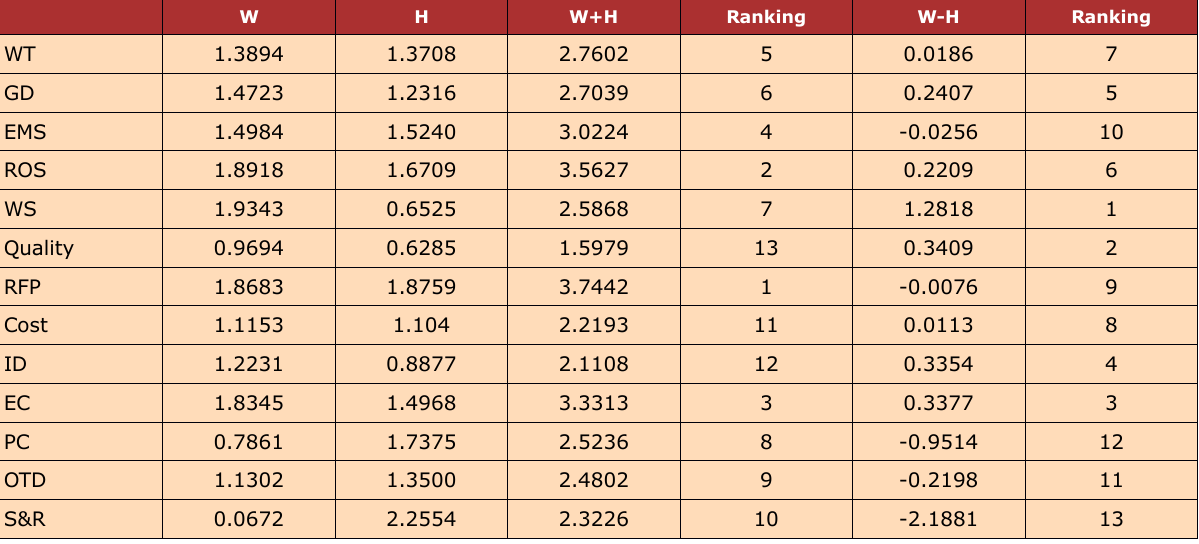
Table 11. Degree of central role